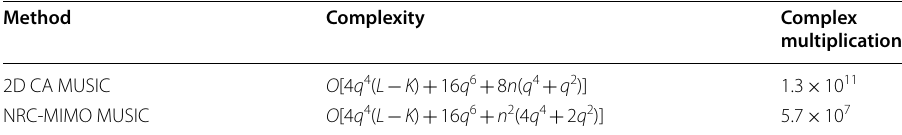
Table 2 Computational complexity of different methods